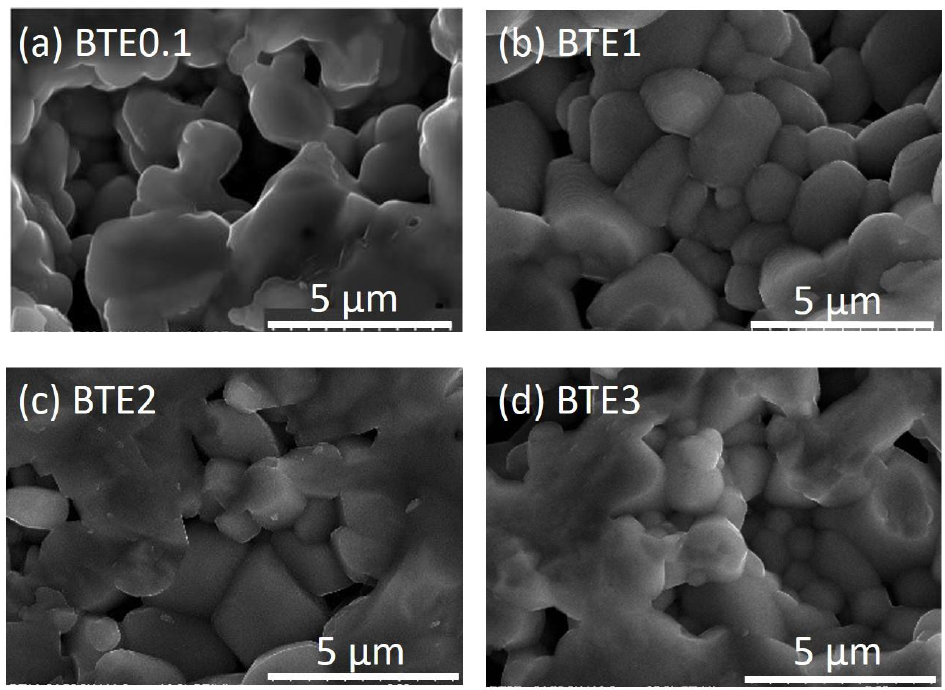
Figure 2. Scanning Electron Microscopy (SEM) images of the microstructure of fractures of ( a ) BTE0.1, ( b ) BTE1, ( c ) BTE2, and ( d )